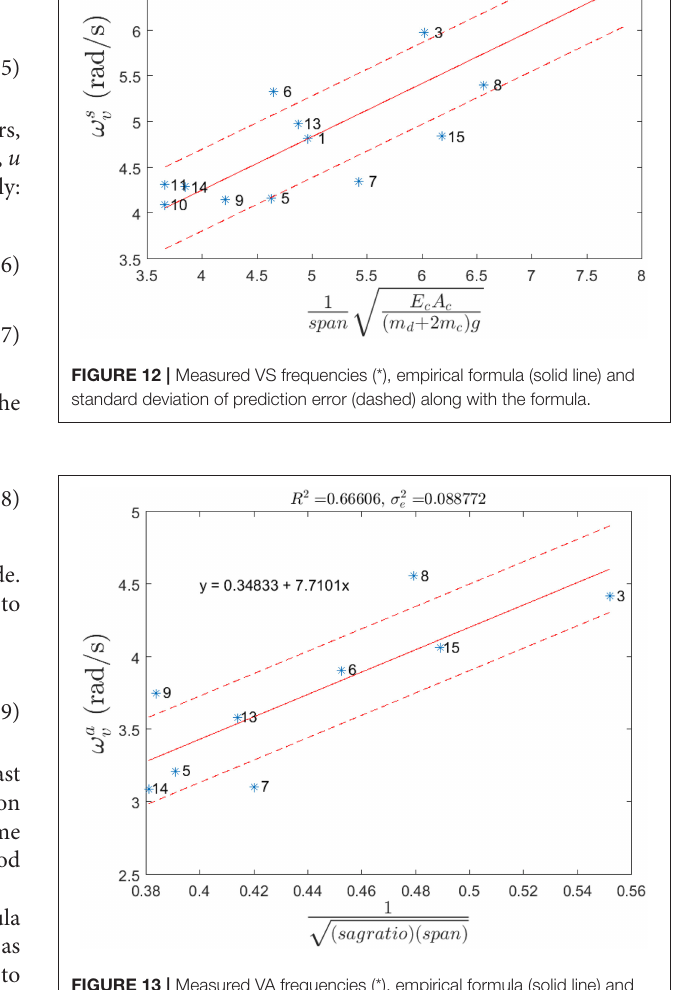
are 50 and 52 m spans, respectively and both share the characteristic of having higher than average camber in their deck, which may contribute to lower than expected torsional symmetric frequencies. When these two footbridges are excluded, the regression has R 2 of 0.96 as shown in Figure 14 . While, there are insufficient data on TA frequencies with only four points to run a regression analysis. Thus, the frequency ratio between the VA and TA modes for the anti-symmetric case is assumed to be the same as for the symmetric modes. As more citizen sensing data will be populated in the database, this assumption can be further